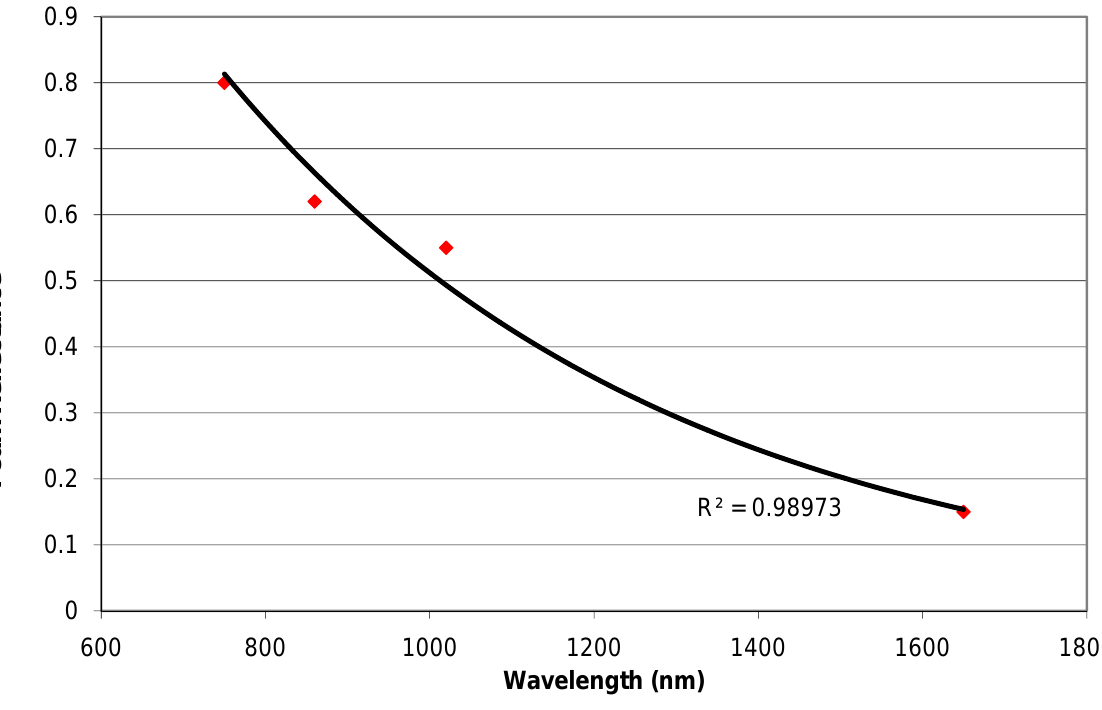
Figure 1. Data of Frouin et al. [33], which suggests an exponential function of wavelength. The correlation is not significant, with only four data points, but it suggests that exponential decay is a starting point upon which we can construct a